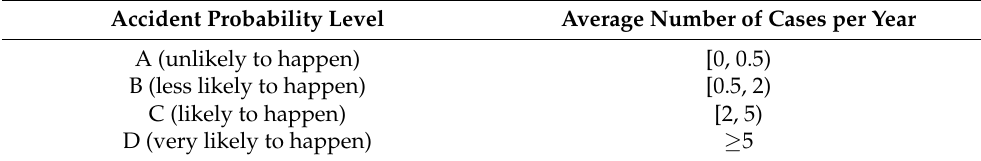
Table 3. Reference standard of the possibility of a hidden danger causing an accident level.